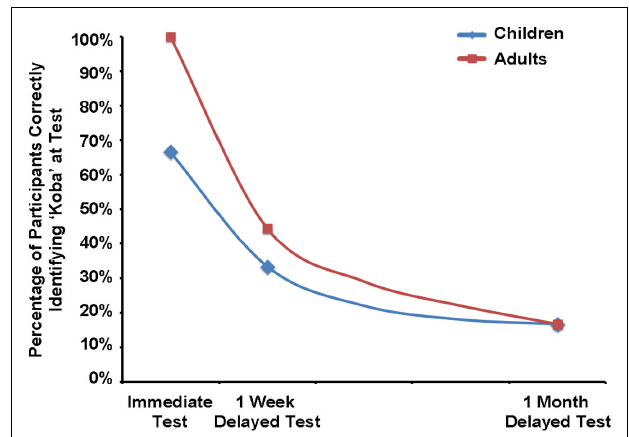
FIGURE 2 | Results of Experiment 1. The percentage of participants (children and adults) correctly identifying the “koba” at the immediate test, 1week delayed test, and 1month delayed test. Participants in this experiment did not receive the memory supports typically included in studies of fast mapping and word